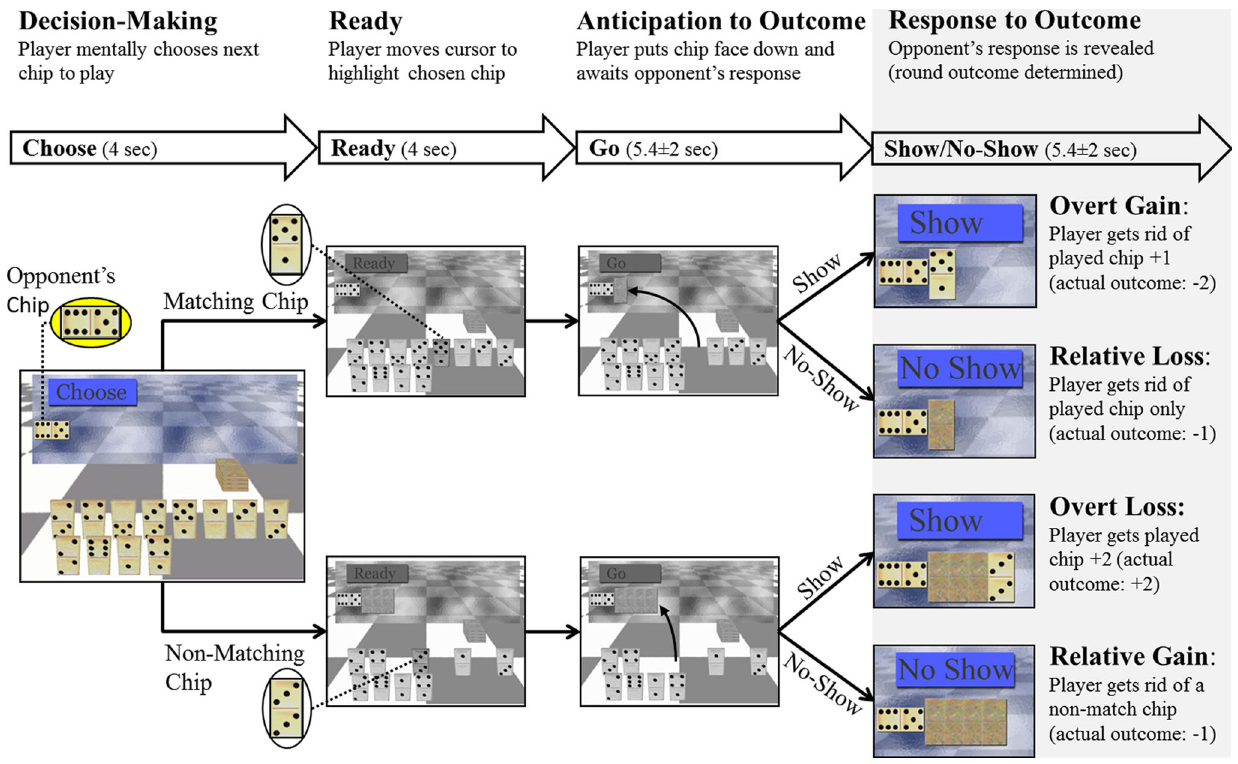
Figure 1. Domino game task. Domino Game Paradigm. The upper panel describes the 4 intervals that comprise each round of the game: Decision Making, Ready, Anticipation to Outcome and Response to Outcome. The latter is the main focus of this study, thus it is highlighted in gray. The duration of each interval and the command (i.e. event) that starts it are described in the bolded arrows below. The lower panel depicts the Domino Game sequence and corresponding consequences. At the beginning of each game the player (participant scanned) gets 12 playing chips and his/her goal is dispose of all 12 within 4 minutes. A constant opponent’s chip (in this example 6:5, shown enlarged in the yellow ellipsoid) to which the player matches one chip in each round of the game, is displayed in the upper left corner of the screen throughout the game. Each round starts with the player instructed to decide what chip he/she will play next by the command ‘Choose’ (Decision-making interval). Then the player is instructed to move the cursor to this chip (Ready interval). The chip can either match the opponent’s (i.e. have one of the numbers match those on the opponent’s chip, upper row, 5:1 in this example) or not (lower row: 3:3; note that this is a later round in the same game). After placing the selected chip face down next to the opponent’s, he/she awaits the opponent’s response (Anticipation of Outcome interval). The opponent can either challenge the player’s choice (‘Show’) or not (‘No-Show’). Based on the player’s choice and the opponent’s response there are four possible consequences for each round (Response to Outcome interval): Show Match (overt gain); No-Show Match (relative loss, as the player could have been rewarded if challenged); Show Non-Match (overt loss) and No-Show Non-Match (relative gain, as the player could have been punished if challenged).